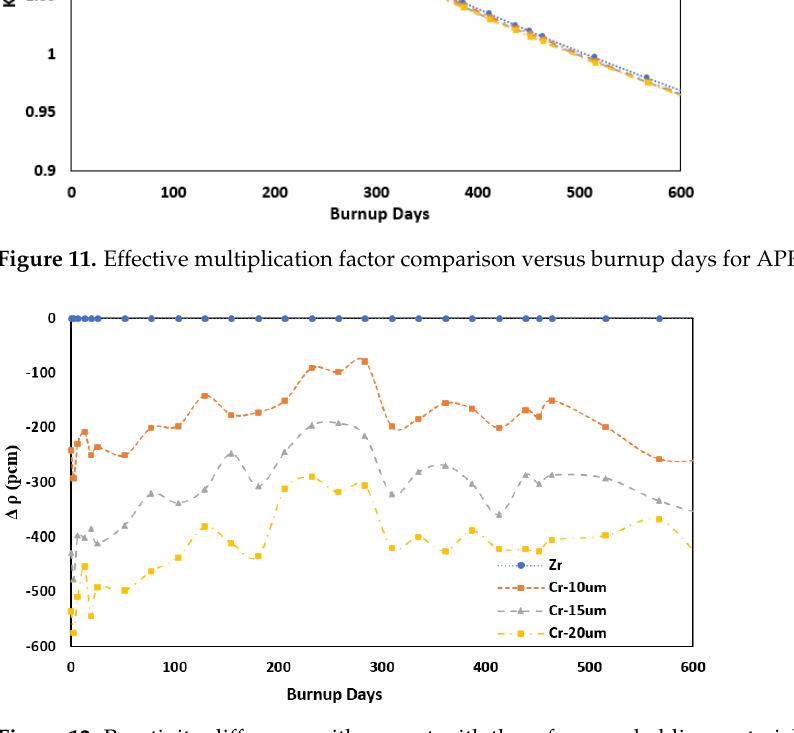
Figure 12. Reactivity difference with respect with the reference cladding material.